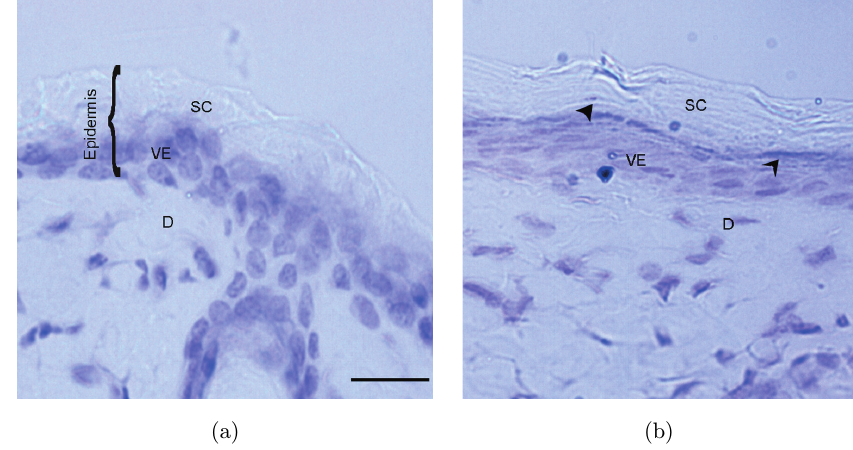
Fig. 2. Images of hematoxylin-stained rat skin tissues (a) without GNP treatment, and (b) with 20 nm GNP treatment. Blue deposits were clearly observed in the SC layer and the SC/VE junction (indicated by black arrow) ( Bar ¼ 50 (cid:1) m; magni¯cation (cid:4) 40). SC, viable epidermis (VE), and dermis (D).